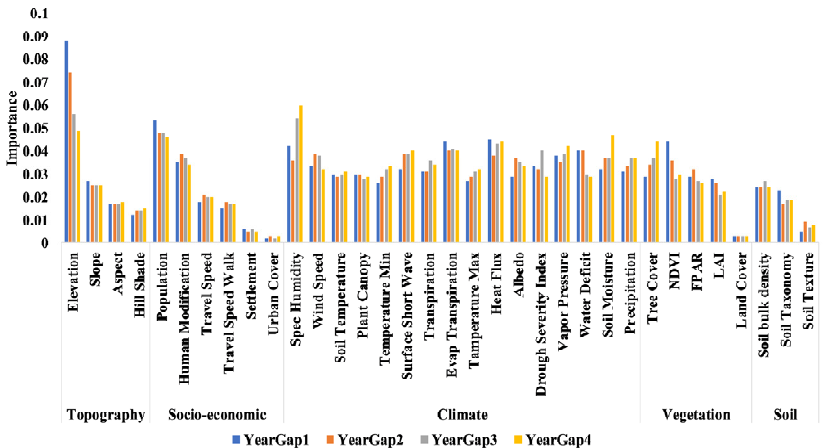
Figure 22. Temporal variable importance analysis based on the RF model.